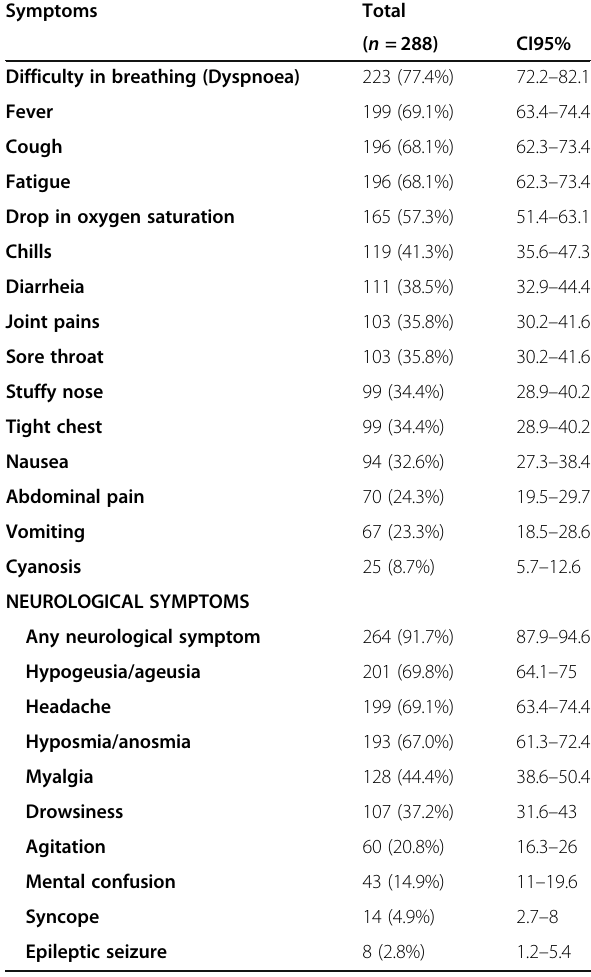
Table 1 Symptoms presented by patients with COVID-19